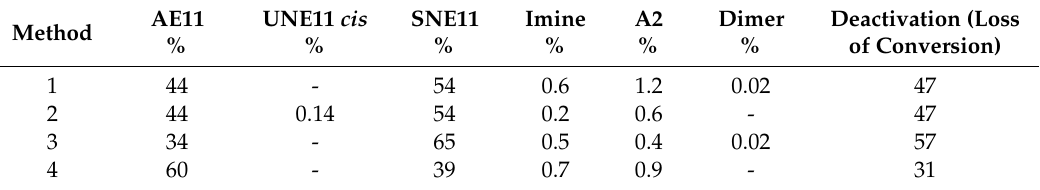
Table 9. 1 : Silent conditions (without ultrasounds) in MeOH solution, 2 : silent conditions in NaOH solution, 3: hydrogenation of UNE11 with catalyst reactivated under sonication, 120 kHz, 100 W in a MeOH solution, 4: hydrogenation of UNE11 with catalyst reactivated under 120 kHz, 100 W in a NaOH solution. AE11 : methyl-11-aminoundecanoate, UNE11 : (9 Z )-10-cyano-9-decenoate, SNE11 : methyl-10-cyanodecanoate. I 2 : secondary imine, A 2 : secondary amine, Dimer : dimer of AE11